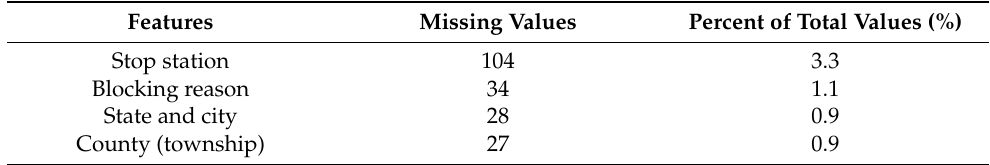
Table 2. Missing data